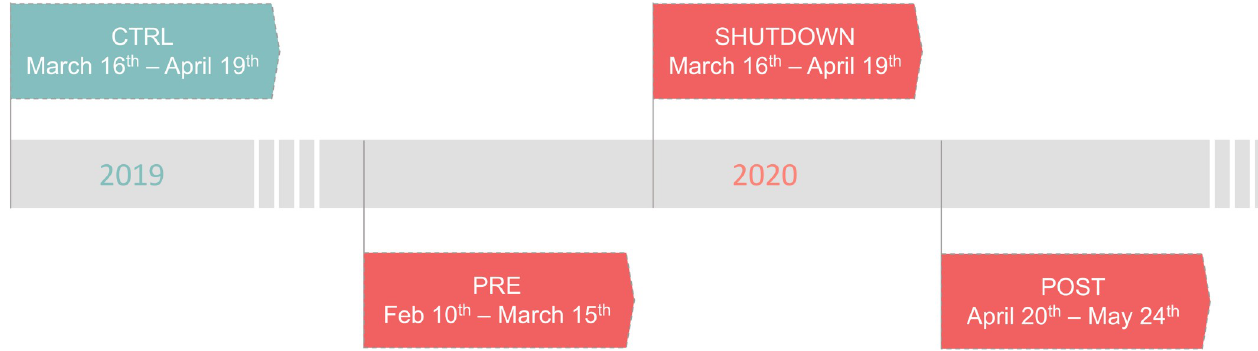
Fig 1. Longitudinal time chart of analyzed time frames before, during and after the COVID-19 shutdown in Berlin, Germany. CTRL = Control; PRE = pre shutdown transition; POST = post shutdown transition; SHUTDOWN = shutdown.